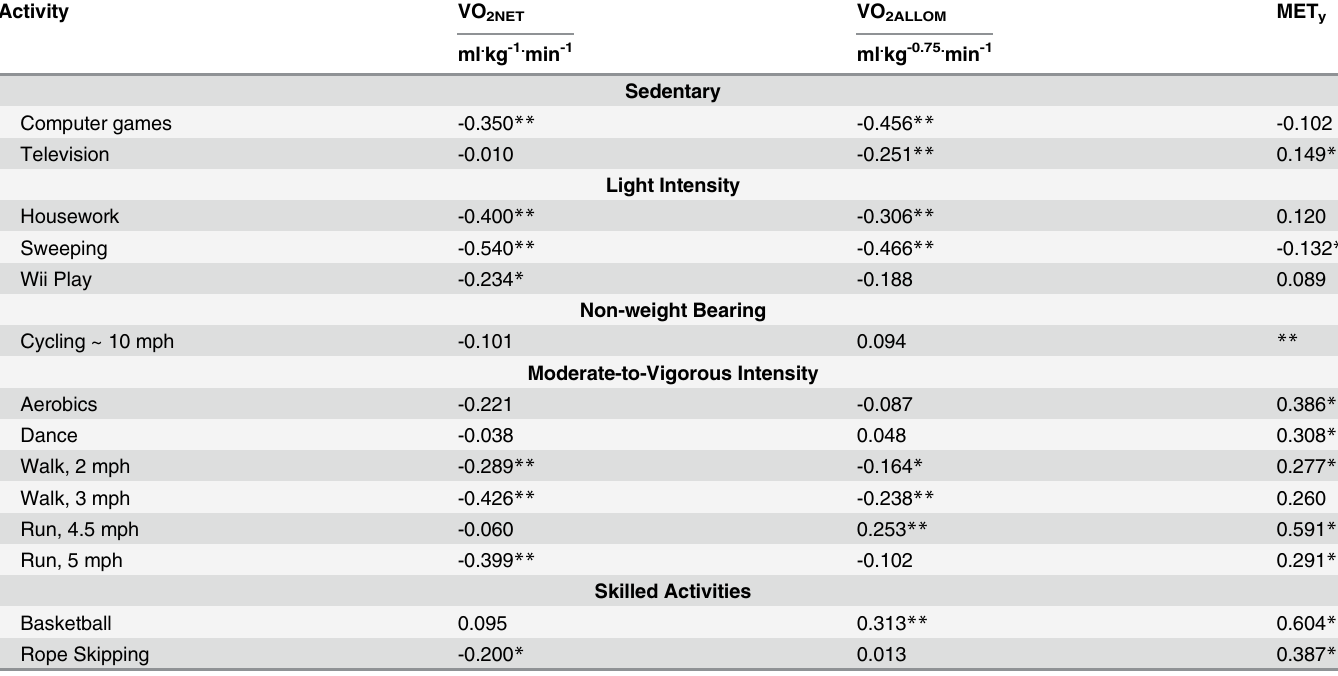
Table 4. Standardized regression coefficients for the EE metrics regressed on age for the 14 activities using the three metrics: VO 2NET , VO 2ALLOM , and YOUTH-MET (MET y ).